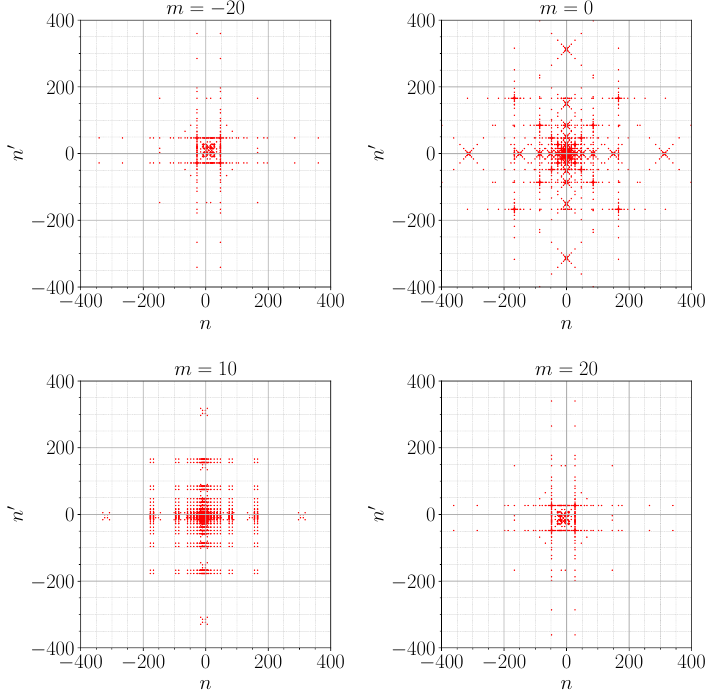
Figure 2: Sampling points generated in the three-frequency space for Λ = 10 4 and = 24. We show cuts at m = − 20, 0, 10, 20. We show only sampling points at low N l frequencies. The actual sampling points are distributed up to | n | , | n (cid:48) | (cid:174) 1800 and | m | (cid:174) 2200.